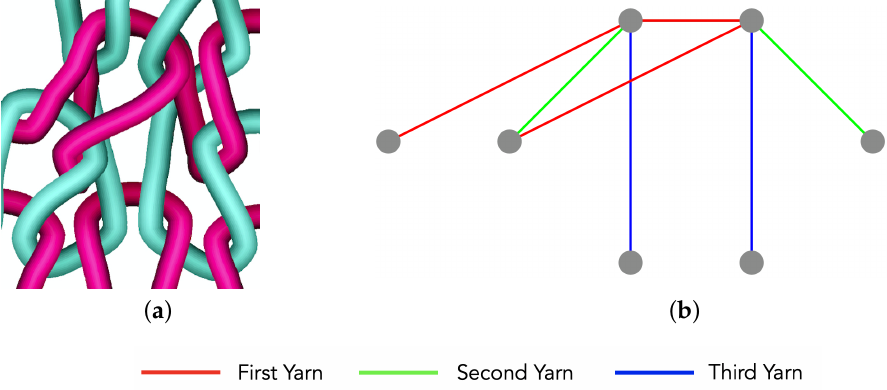
Figure 12. Yarn order zoom-in at location (4, 3) in the yarn topology graph of Figure 11: ( a ) Simulated knitted pattern. ( b ) Corresponding zoom-in topology